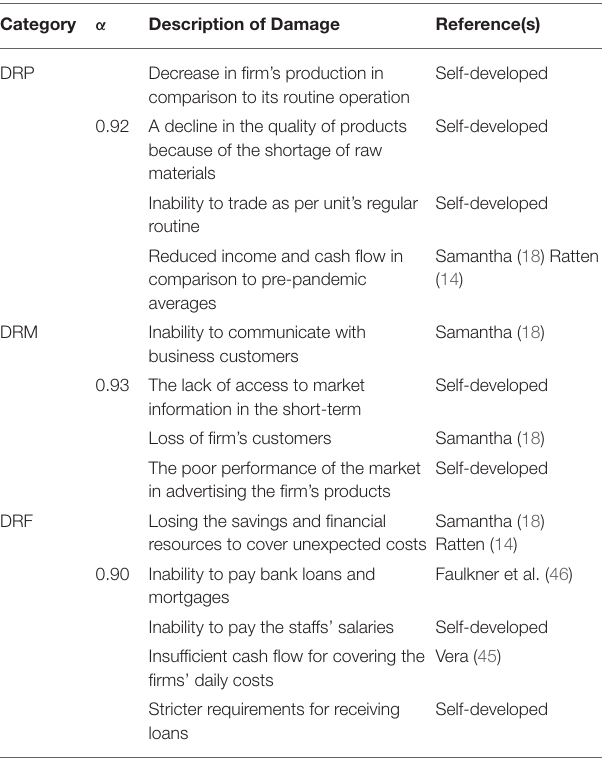
TABLE 2 | Description of responses in adaptive and passive behaviors of MSEs’ managers in the COVID-19